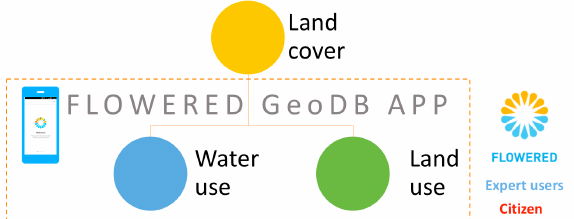
Figure 4. Data collected by expert users.